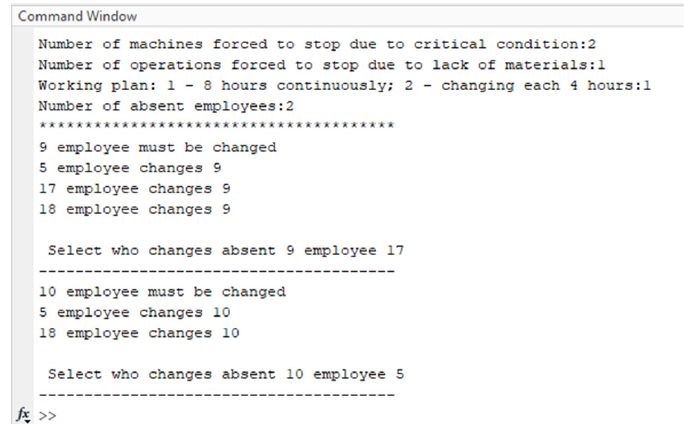
Figure 8. Entered information, 2nd case.